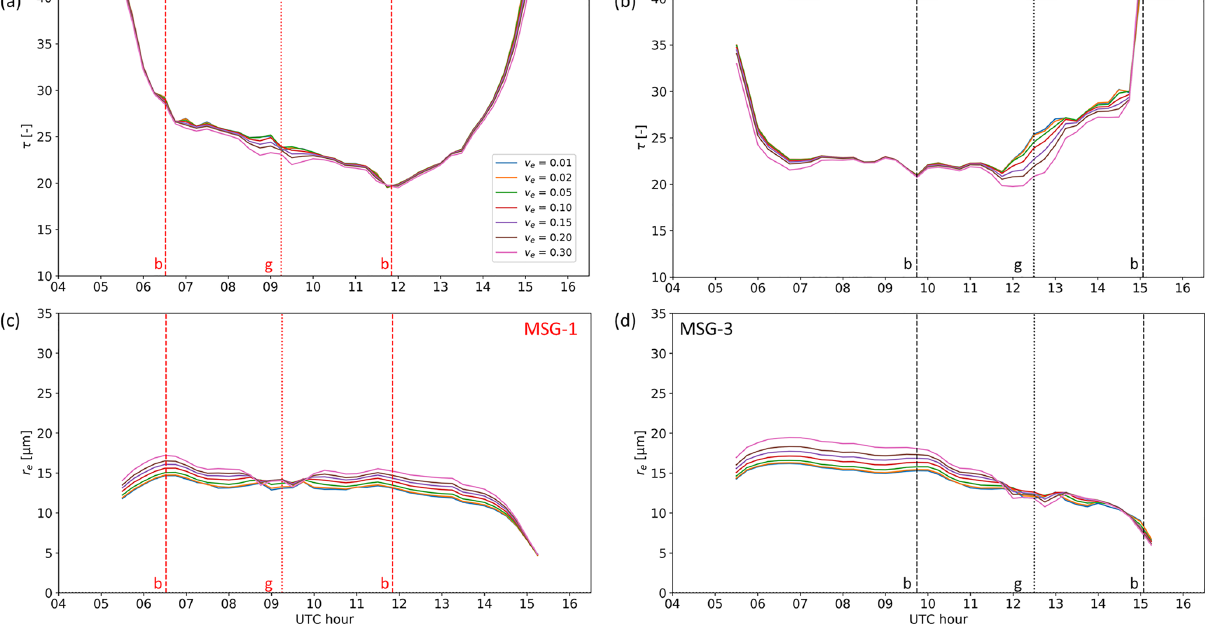
Figure 13. CPP retrievals of τ (a, b) and r e (c, d) based on the 3.9µm channel, shown separately for MSG-1 (a, c) and MSG-3 (b, d) , for the seven values of ν e examined on 20 March 2017 over the continental region shown in Fig. 1. The vertical lines represent cloud glory (dotted, denoted with “g”) and cloud bow (dashed, denoted with “b”) geometries for MSG-1 (red) and MSG-3 (black).